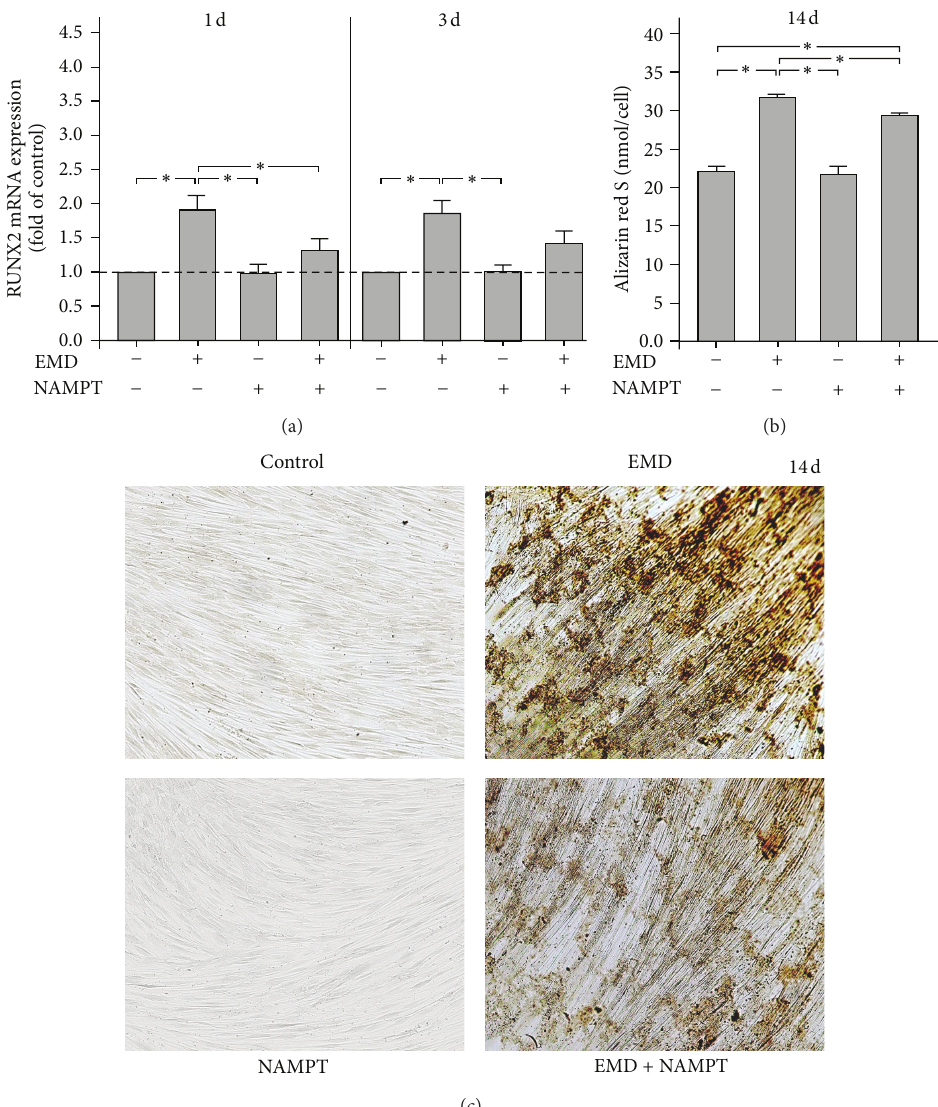
Figure 3: Effect of EMD on the RUNX2 (a) mRNA expression in the presence and absence of NAMPT (100ng/mL) at 1d and 3d. Untreated cells served as control. All experiments were performed in triplicate and repeated at least twice. Mean ± SEM ( 𝑛 = 18 ); ∗ significant ( 𝑃 < 0.05 ) difference between groups. Effect of EMD on the calcium accumulation in the presence and absence of NAMPT (100ng/mL) in cultures of PDL cells ((b) and (c)). Untreated cells served as control. The calcium accumulation was analysed by alizarin red S staining, visualized by microscopy (c), and quantified by elution with cetylpyridinium chloride (b) at 14d. All experiments were performed in triplicate and repeated at least twice. Mean ± SEM ( 𝑛 = 12 ); ∗ significant ( 𝑃 < 0.05 ) difference between groups. Images from one representative donor are